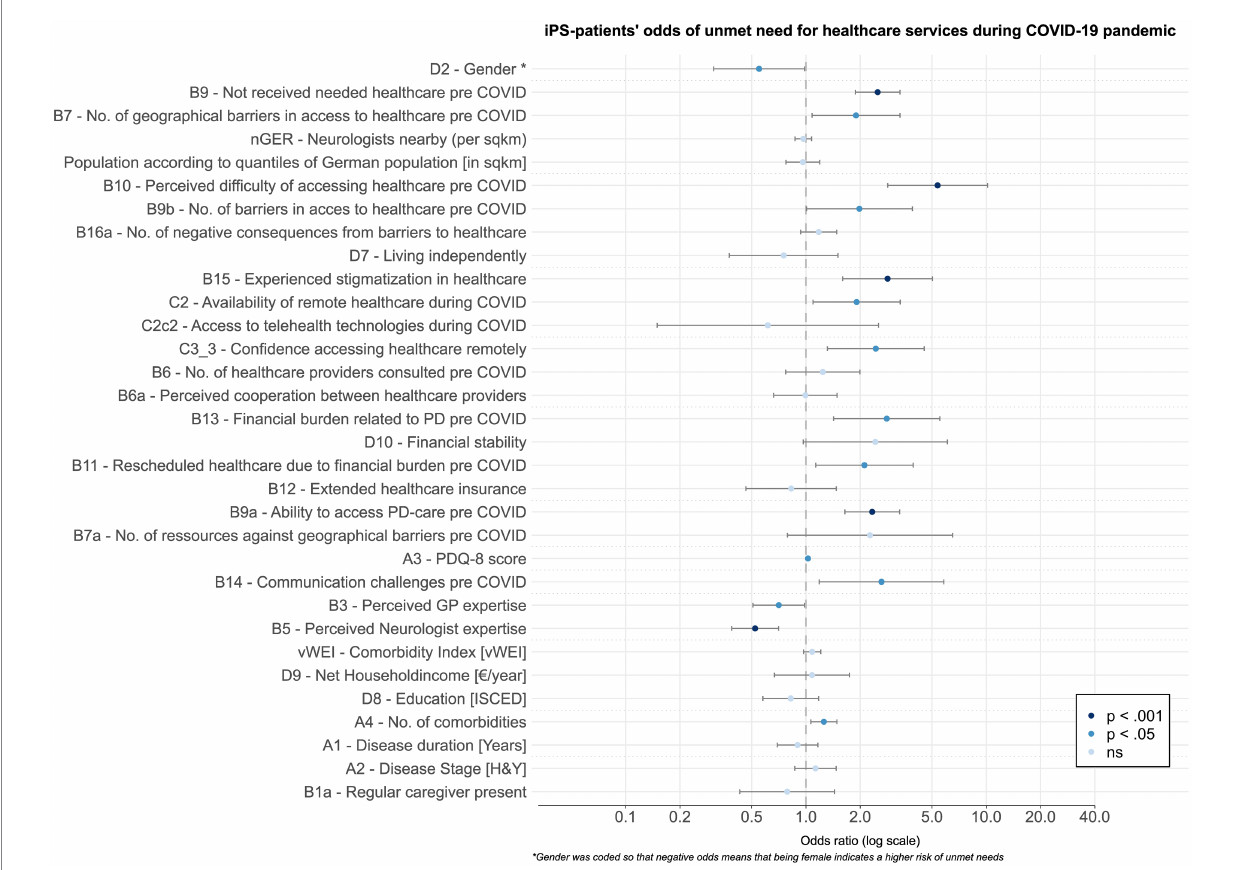
FIGURE 3 Odds ratios for all items in terms of perceived inadequate healthcare during the pandemic. Odds were determined via GLM and coded so that higher values indicate affirmation of the question that healthcare was needed but this need remained unmet during the COVID-19 pandemic. The dashed lines indicate the distinct domains according to Zaman et al., whereas significance is illustrated as the color of the dot, with two distinct levels of